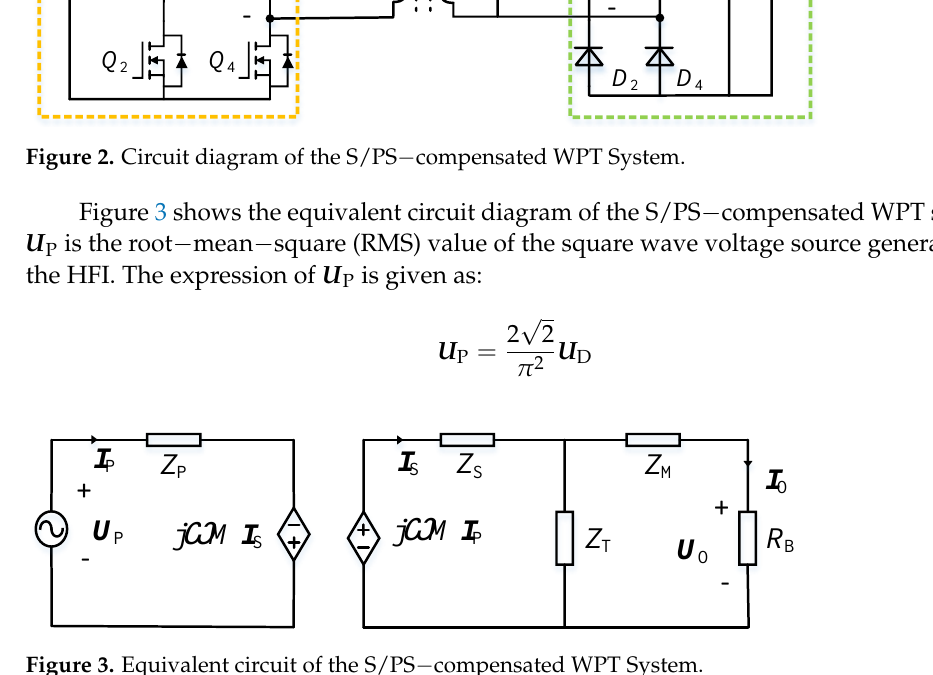
Figure 3. Equivalent circuit of the S/PS−compensated WPT System.